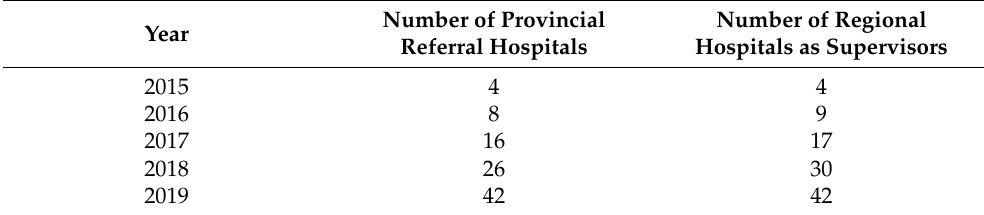
Table 1. Development of Telemedicine Locus in Indonesia. Number of Provincial Number of Regional Year Referral Hospitals Hospitals as Supervisors 2015